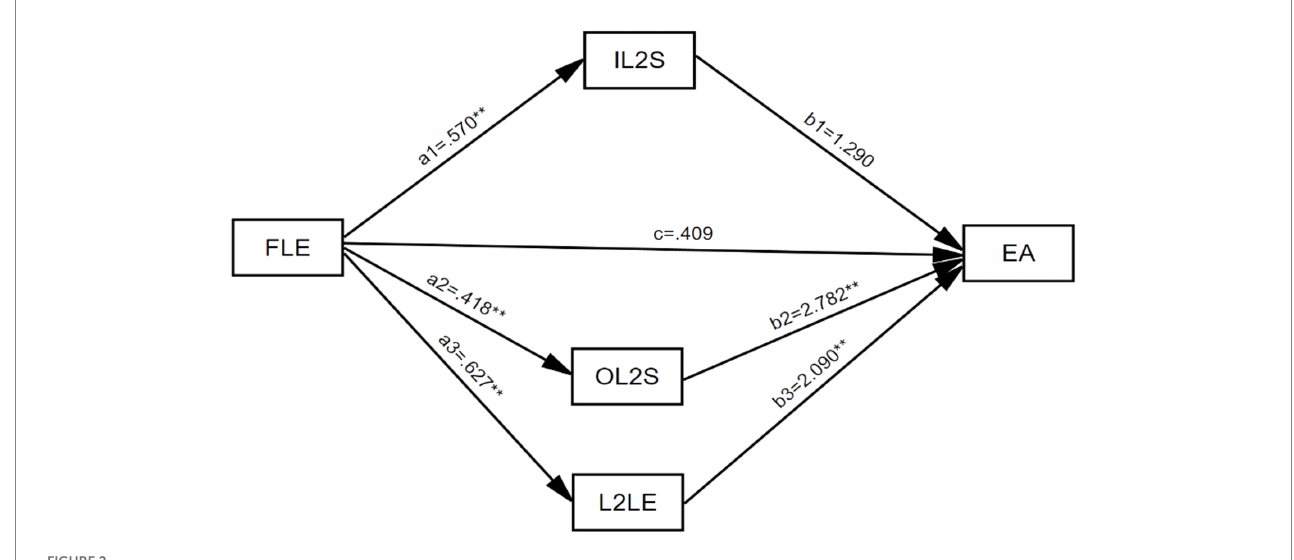
FIGURE 2 ** p ≤ 0.01, EA, English achievement.